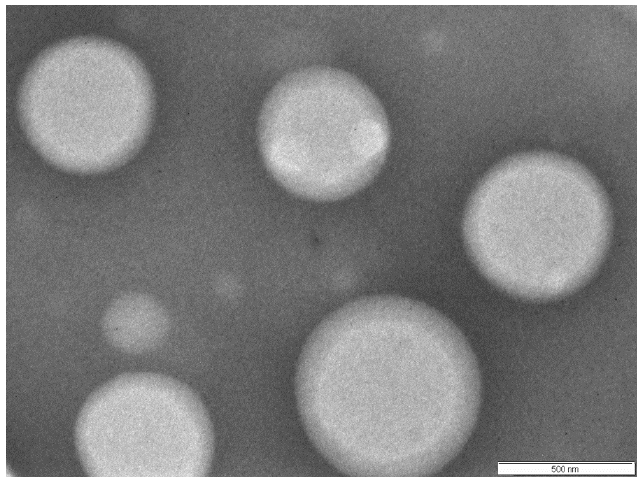
Figure 4. Size and surface morphology of freeze-dried chitosan nanoparticles, as determined by transmission electron microscope (Morgagni TEM, FEI, Eindhoven, The Netherlands).